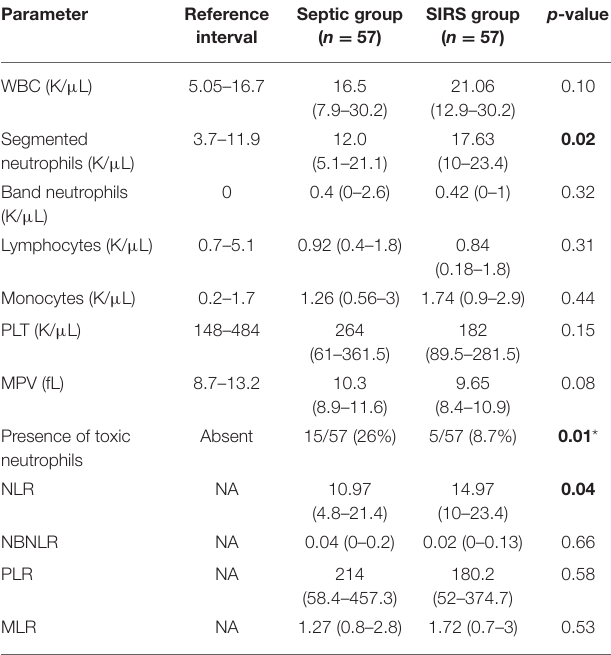
TABLE 2 | Receiver-operating characteristic curves of continuous variables included in the study.